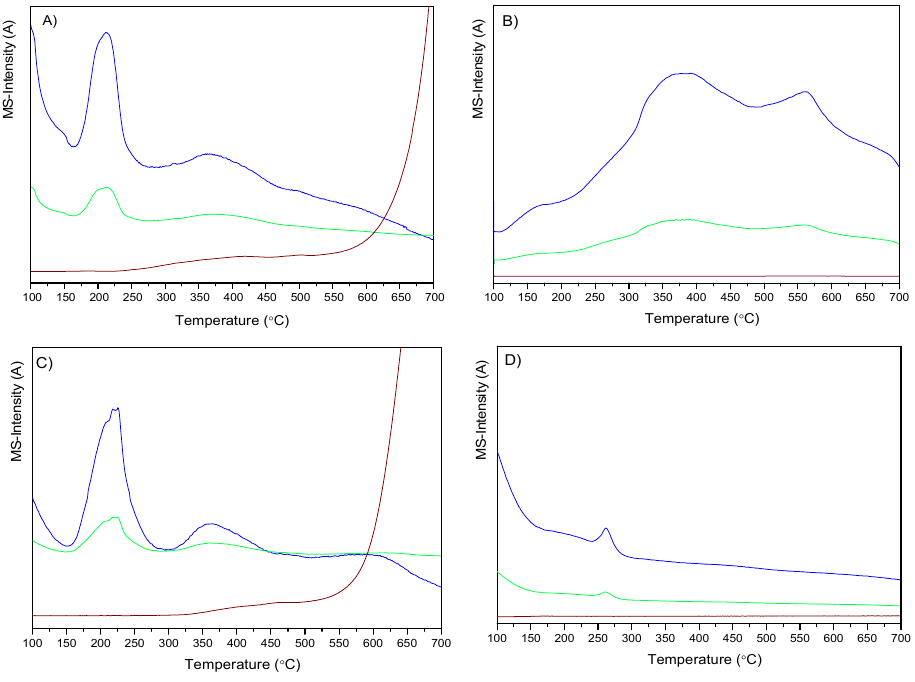
Figure 3. Mass profiles of H 2 -TPR of ( A ) CuMo x C/H, ( B ) CuMo x C/CNT, and ( C ) CuMo x C/rGO under H 2 and ( D ) CuMo x C/H under He. m / z 18 (blue); m / z 17 (green) m / z 15 (wine).